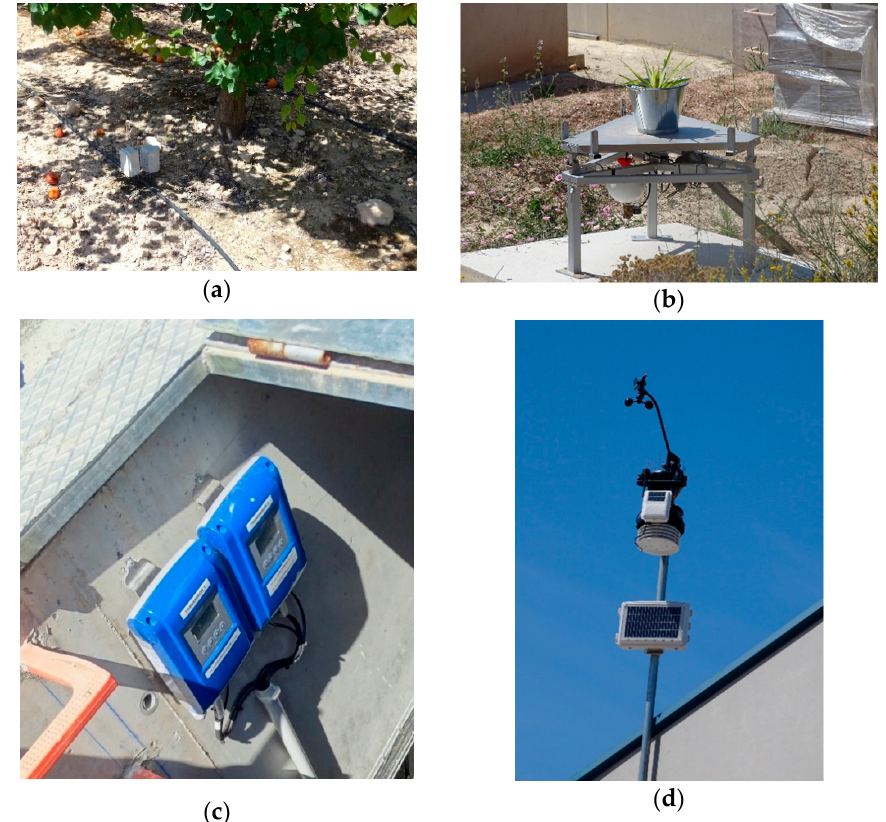
Figure 8. ( a ) Capacitive soil sensor, ( b ) Weighing lysimeter, ( c ) Water quality analyzer, and ( d ) Figure 8. (a) Capacitive soil sensor, (b) Weighing lysimeter, (c) Water quality analyzer, and (d) Agrometeorological station. Source: Agrometeorological station. Source: Own.